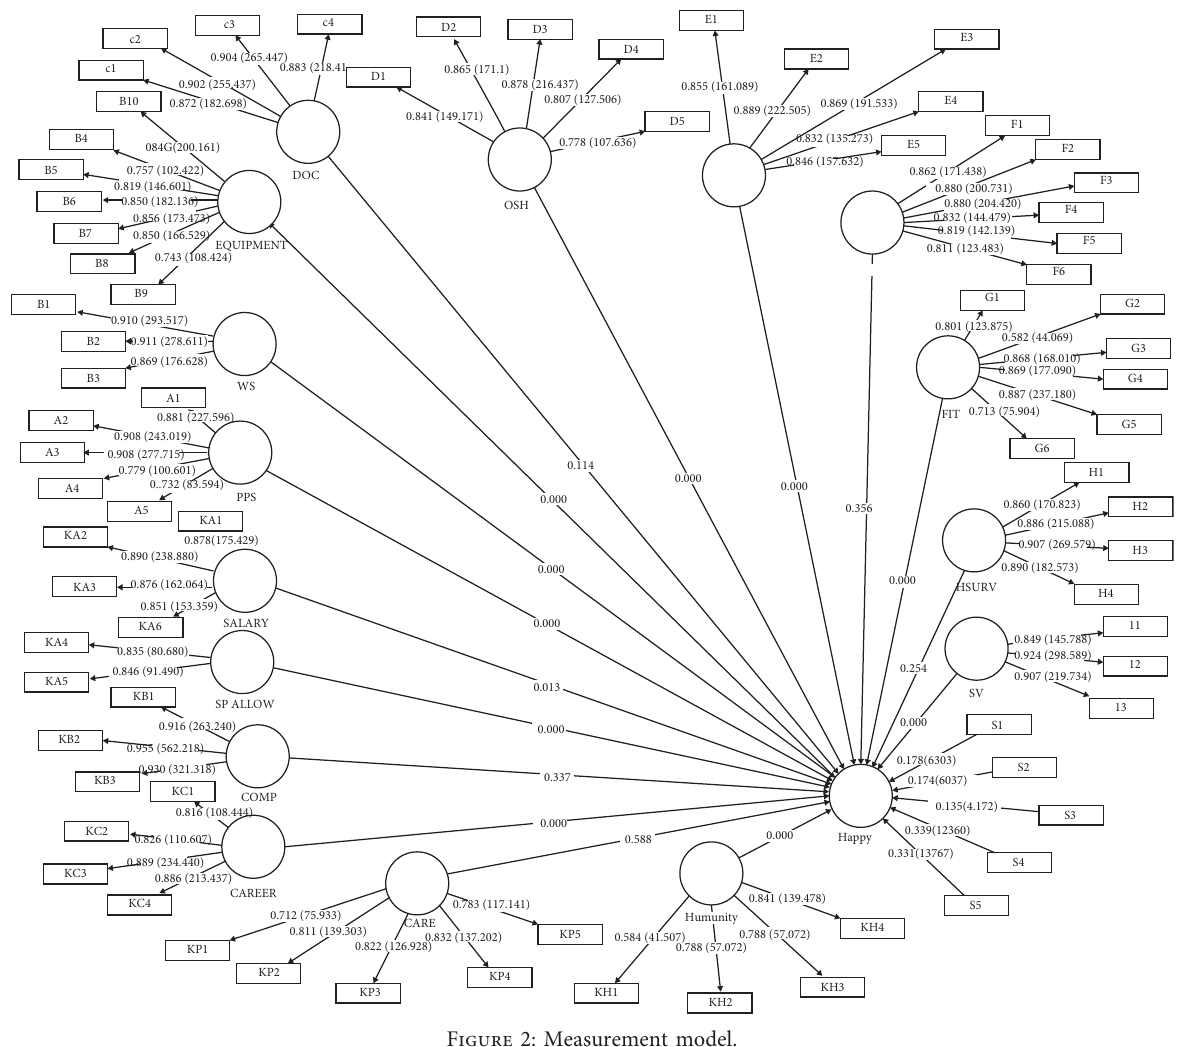
Figure 2: Measurement